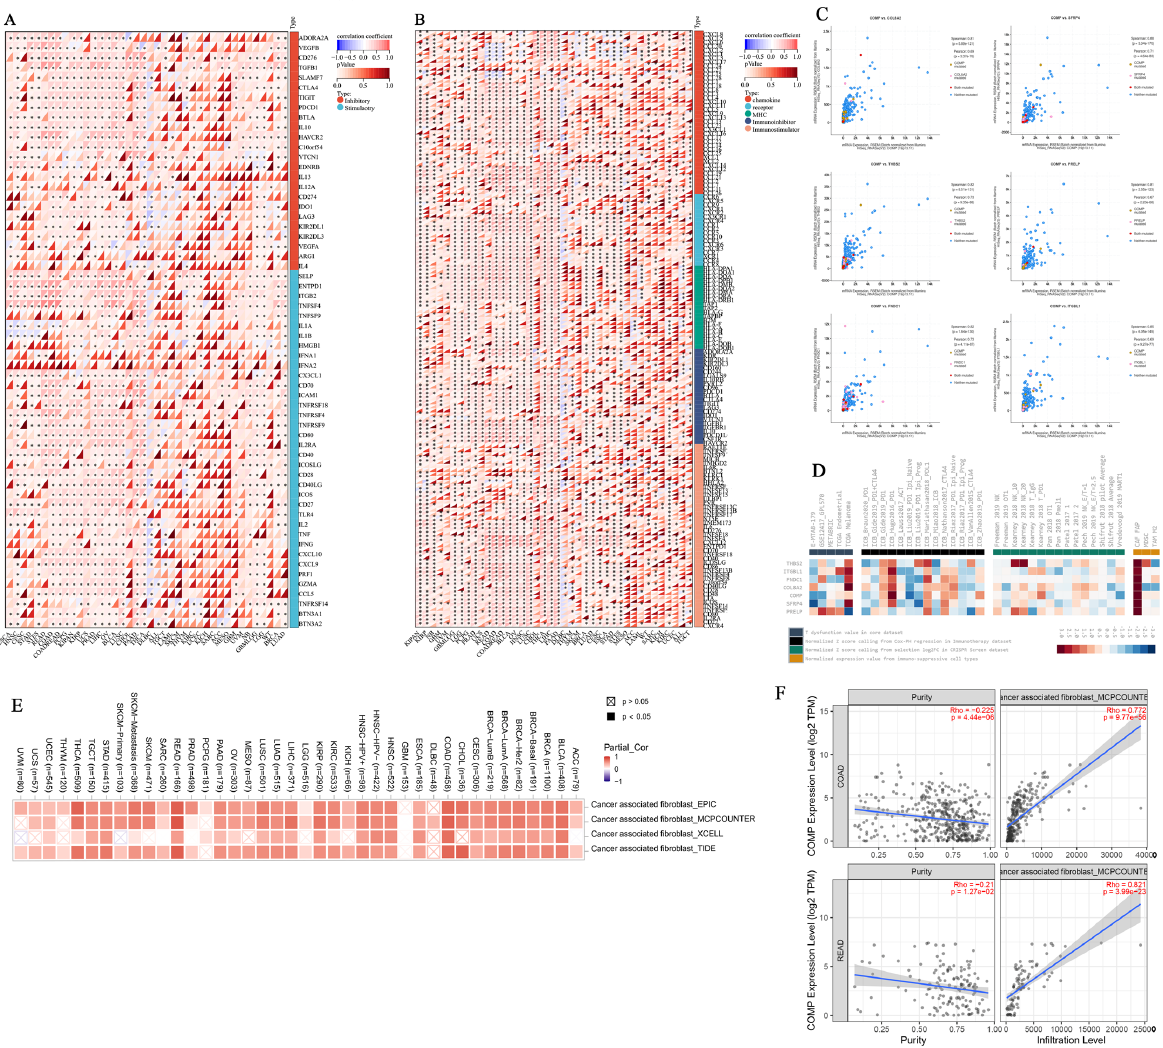
Figure 7. The impact of COMP in immune regulators, immune checkpoint-related molecules, and tumor immune microenvironments. ( A ) The correlation between COMP and immune regulators. ( B ) The correlation between COMP and immune checkpoint-related genes. ( C ) The co-expressed genes of COMP with Spearman’s correlation coefficient greater than 0.8. ( D ) The association be- tween COMP-related genes and four immunosuppressive indices. ( E ) The correlation between COMP and CAFs in pan cancers. ( F ) The correlation between COMP and CAFs in COAD and READ.